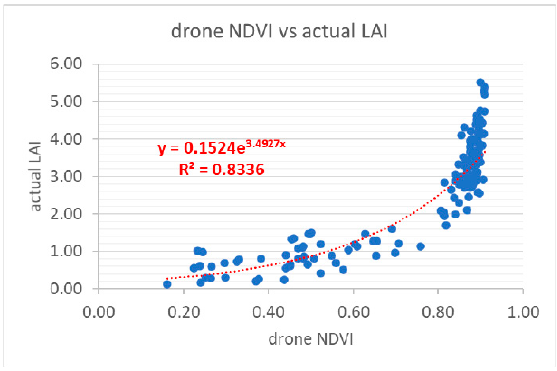
Figure 11. Exponential relationship (with R 2 = 0.8336) between drone NDVI and actual LAI values at early crop stages.